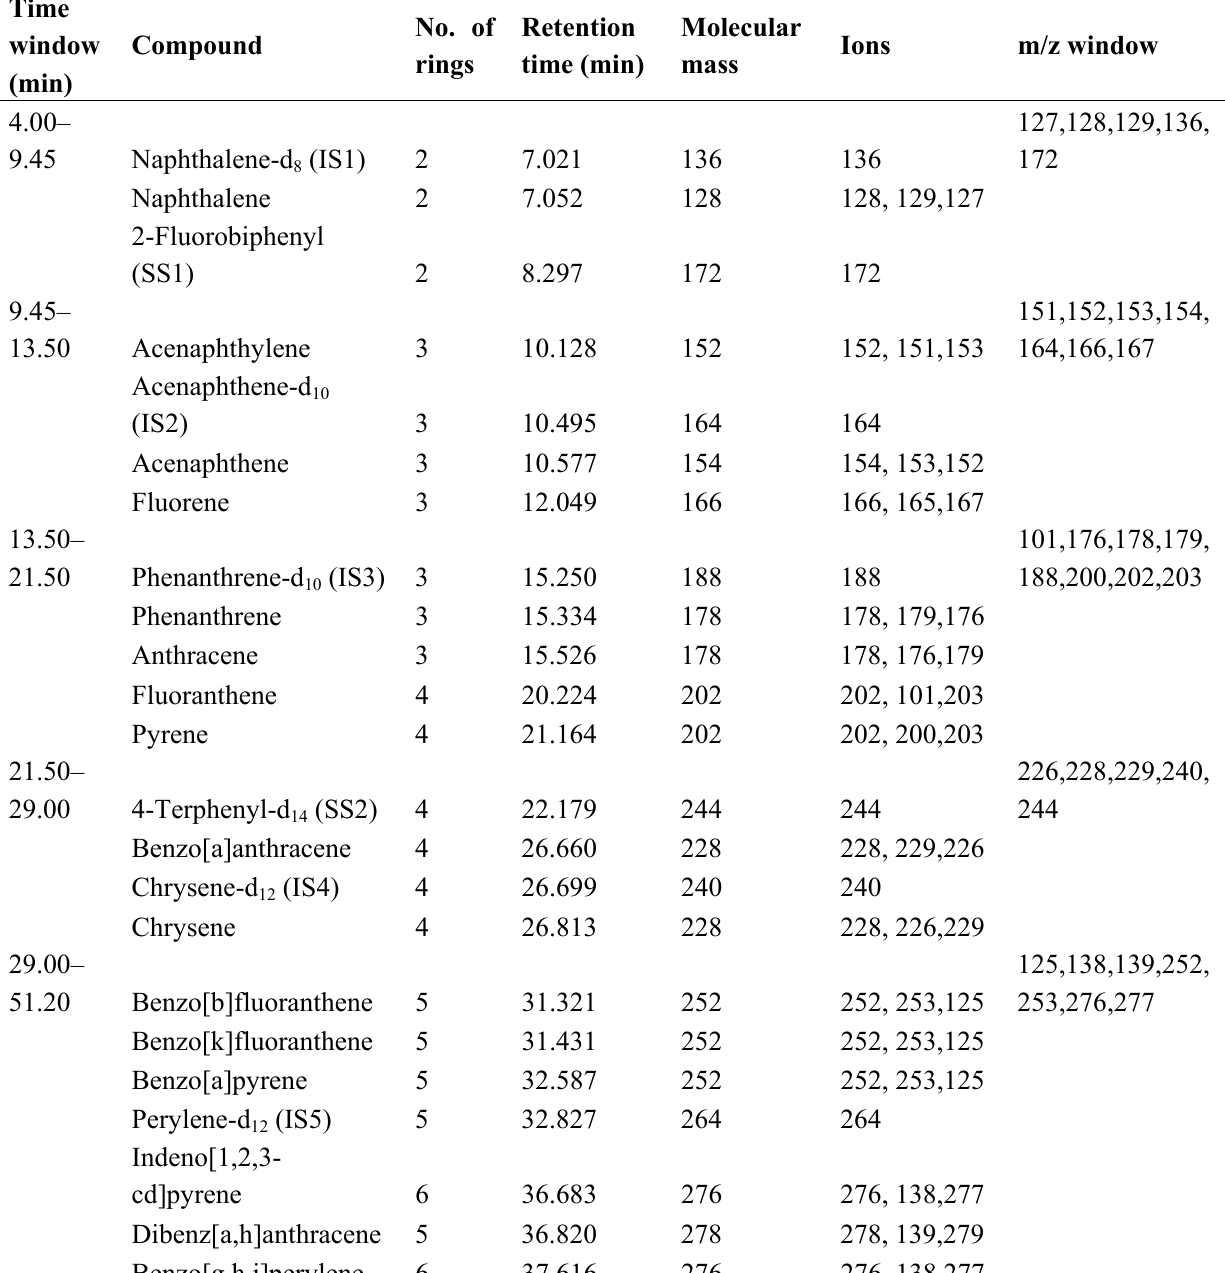
Table 1. GC-MS conditions under time scheduled selected ion